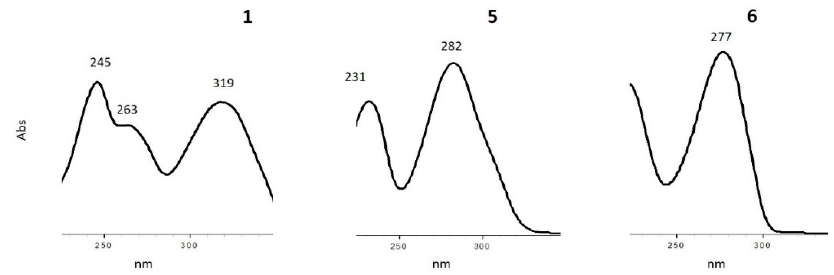
Figure 10. In-line UV spectra (220–350 nm) corresponding to Figure 9, compounds 1, 5, and 6. The mixture of oxaziridines 3 and 4 was incubated in water in the dark at 37 or 60 ◦ C. Compounds 3 and 4 transformed (principally) to aldonitrone 1 and to two other products (5 and 6). Aldonitrone 1 in-line mass spectrum (positive electrospray) showed signals at m/z = 324.0808 amu, and m/z = 170.0565 amu, which correspond to the sodium adduct of general formula C 11 H 15 N 3 O 7 Na (1) and to the nucleobase fragment C 6 H 8 N 3 O 3 , respectively. The in-line mass spectrum of 5, the aldehyde derivative, showed signals at m/z = 295.0544 amu, and m/z = 141.0299 amu, which correspond to the sodium adduct of general formula C 10 H 12 N 2 O 7 Na and to the nucleobase fragment C 5 H 5 N 2 O 3 , respectively. Finally, the in-line mass spectrum of 6, the amide derivative, showed signals at m/z = 324.0807 amu, and m/z = 170.0567 amu, that correspond to the sodium adduct of general formula C 11 H 15 N 3 O 7 Na and to the nucleobase fragment C 6 H 8 N 3 O 3 , respectively (Figure S4). Both aldehyde and amide are common products of hydrolysis (aldehyde 5) or isomerization (amide 6) of aldonitrone (Scheme 4).